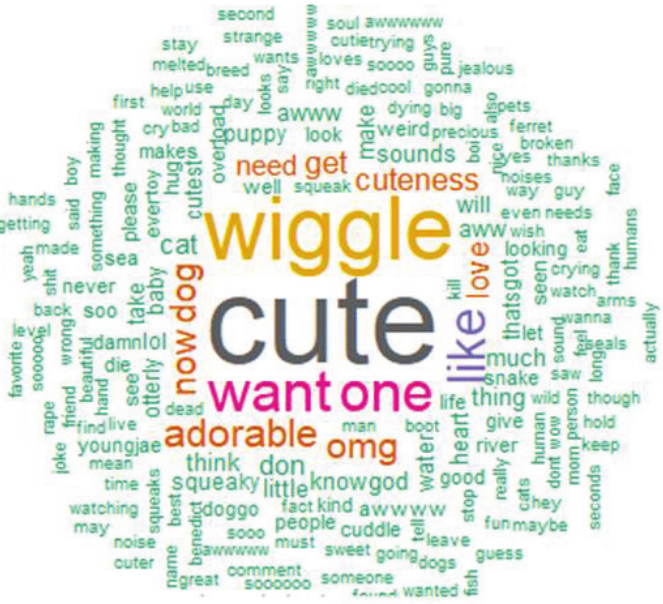
Figure 4. Wordcloud depicting the nature of comments for one of the pet otter influencer videos (de- fined as the most viewed and the most popular videos; > median views, and > median like:view ratios) selected for comment content analysis (those with > 1,000 comments). The wordcloud shown here is for Video 2 (see Table 2; wordclouds for the other four videos are given in Appendix 3). Font size is relative to the frequency at which each of the words appears in the comments; stopwords and profanities have been removed (see Methods).